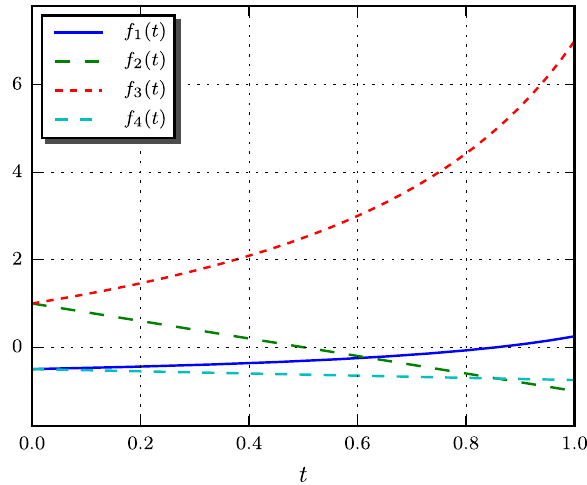
FIG. 3. Plots of the correction functions for the initial con- figuration shown in Fig. 2(a) and a ¼ − 2